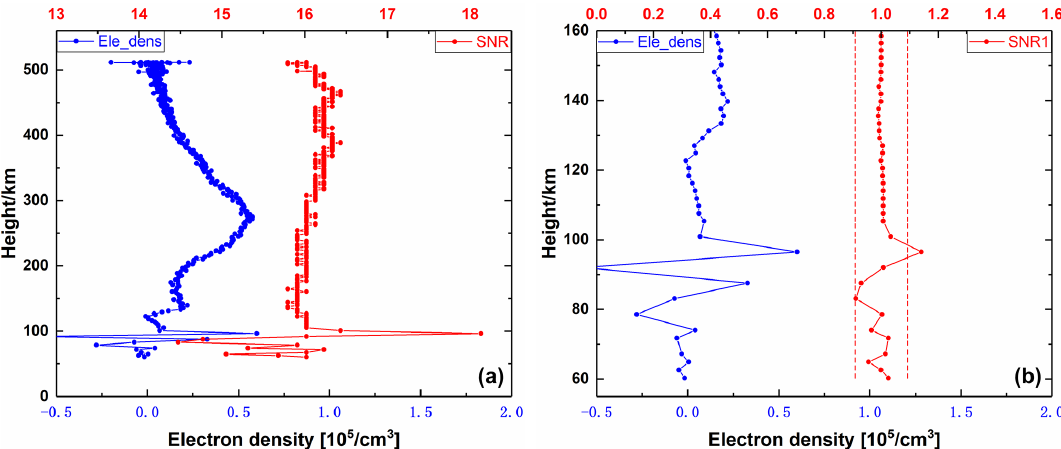
Figure 1. Schematic diagram of G06 single-layer E s sounding. Panel (a) shows the electron density profile of the G06 occultation event and the SNR profile at 06:56GPST on 14 August 2018. Panel (b) shows the electron density profile and normalized SNR profile within 60–160km at the same time, and the red dotted line is the SNR1 ± 3std boundary vertical.